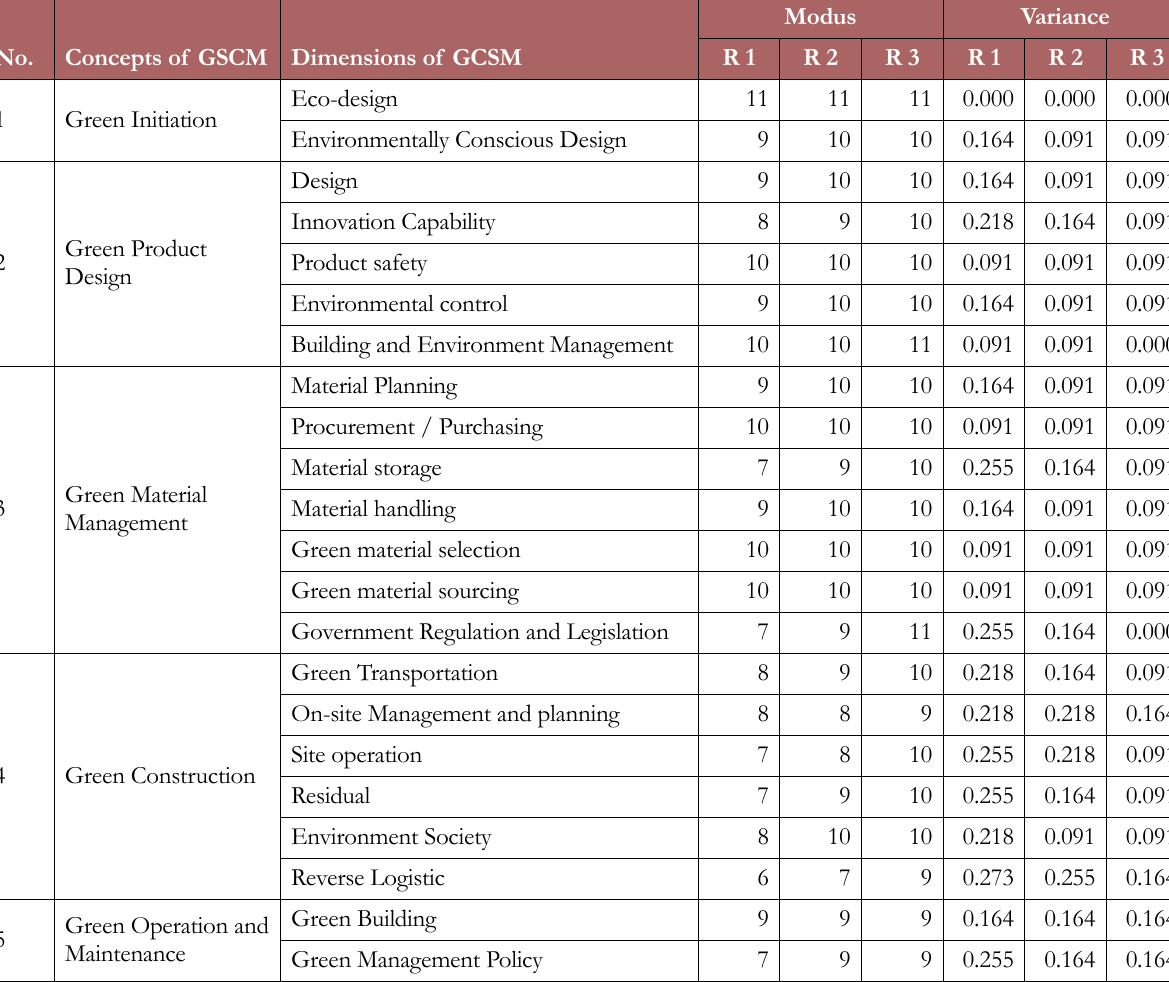
Table 6. Delphi Results for the GSCM Dimensions in the Construction